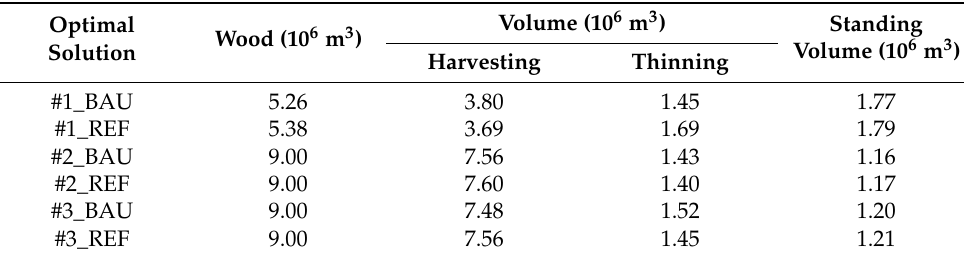
Table 6. Timber provision, average volume harvested and volume of ending inventory for the three optimal-solutions, under current (BAU) and changing (REF) climate conditions. Optimal